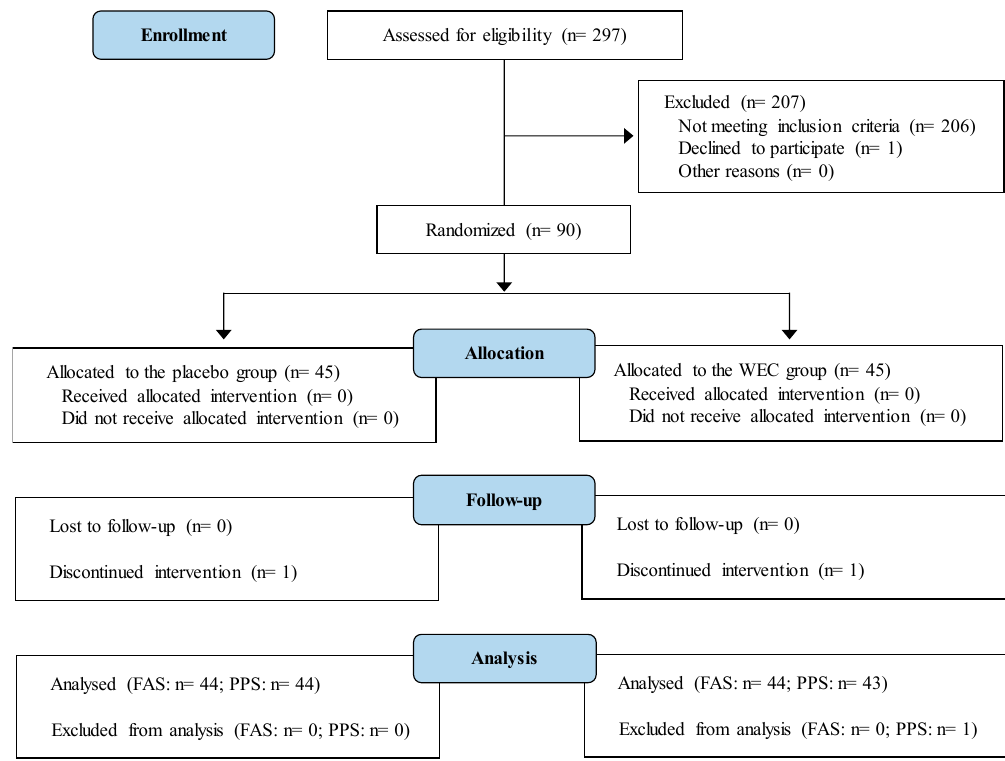
Figure 1. Study flow diagram (CONSORT 2010).